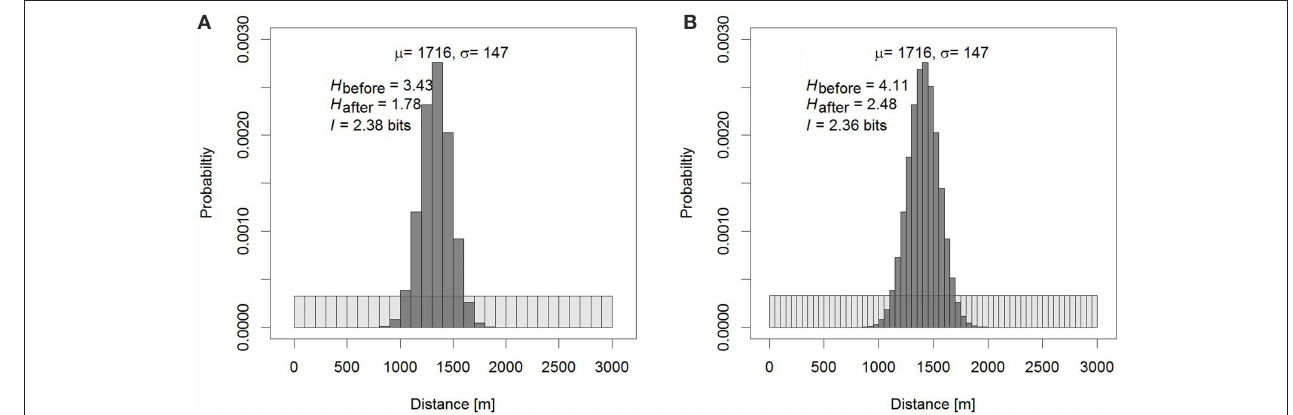
deviation σ (dark gray bins). The difference between our prior uncertainty FIGURE 1 | Information of the dance as the reduction in uncertainty and the uncertainty that remains after observing the dance is the in the dance. (A) If we know that a bee has foraged between 0 and information communicated by the dance. The uncertainties, the entropies 3km, but not where, our prior knowledge attributes equal probabilities to the possibilities that the bee has visited any of 30 100m bins (light H , depend on the size of the bins, but the information I does not. In × (B) , smaller bins have been chosen, and the entropies increase compared gray bins). Knowing how the dance translates into distance, after to (A) , but the information does not change other than that the observing the dance our uncertainty is reduced to a narrower area measurement of I is more around the estimated distance µ , which is dependent on the standard